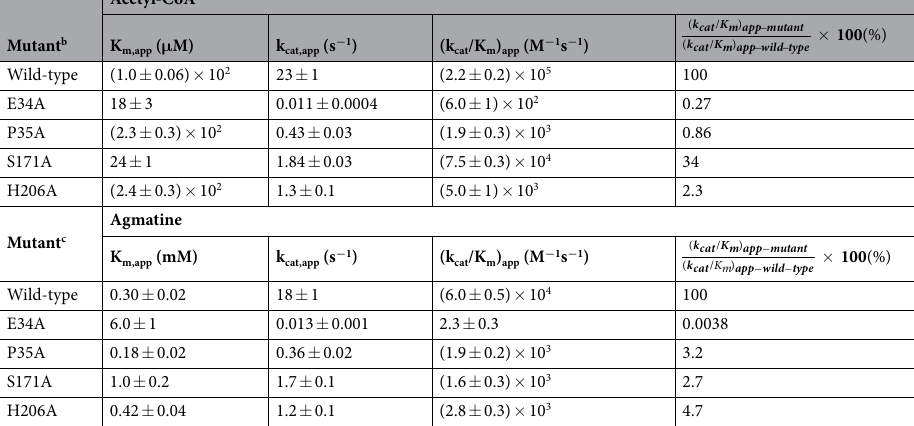
Table 5. Steady-state Kinetic Constants for AgmNAT Site-directed Mutants a . a Kinetic constants are reported as ± standard error (n = 3). b Reaction conditions − 300 mM Tris-HCl pH 8.5, 150 µ M DTNB, varying concentration of acetyl-CoA, and saturating concentration of agmatine from 0.1–500 mM. c Reaction conditions − 300 mM Tris-HCl pH 8.5, 150 µ M DTNB, varying concentration of agmatine, and saturating concentration of acetyl-CoA from 10–2500 μ M.